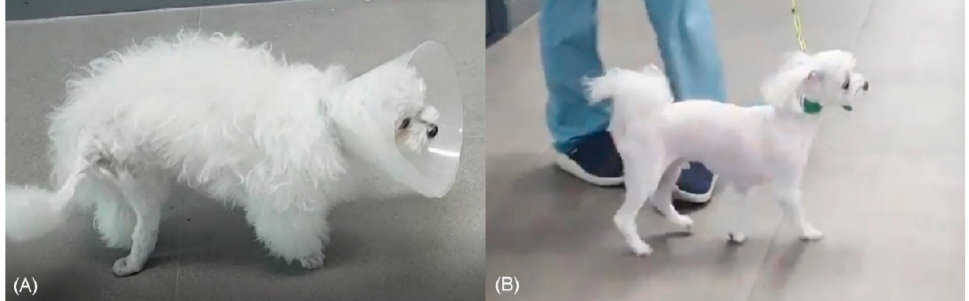
Figure 1. Preoperative and postoperative patient images. Posture observation before ( A ) and after ( B ) sciatic nerve neurorrhaphy and tarsal arthrodesis. The muscle atrophy of the right pelvic limb preoperatively is evident ( A ). At 21 months postoperatively ( B ), the muscle mass increased considerably, and the patient was able to bear weight on the operated limb.